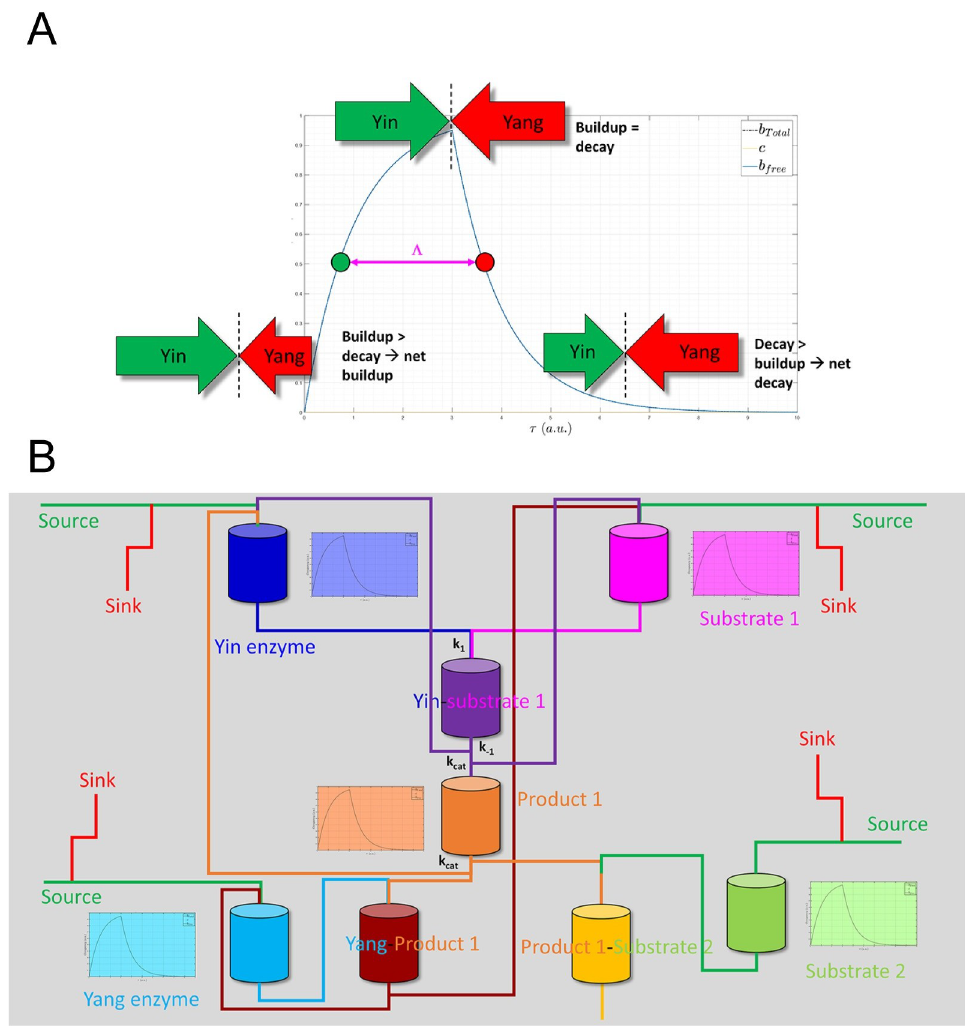
Fig 5. (A) Buildup and decay of a Yin (typically an enzyme), together with its substrate, product (and substrates thereof), Yang across their accessible states, as depicted by a plumbing system consisting of pipes, vessels, and valves. A given function-generating system is constituted from an interdependent collection of m such systems. Each system is maintained at non-equilibrium (analogous to “pressurization”) via continuous inputs and outputs of molecular species (“fluxes”). The dynamic fluid levels within the (n � m) member vessels of the overall system, which define its instantaneous state, are solved by integration of the m MDE collections ({ d γ k ( t )/ dt = rate of entry to state k–rate of exit from state k} i , where k = 1, 2, 3, ... , n, and i = 1, 2, 3, ... , m). The vessels may be connected in series or parallel. The flow rates to/from each vessel depend on the input and output valve settings (representing both the intrinsic and extrinsic free energy barriers in this simplified example), which are governed by the overall state of the system (constituting a feedback loop). (B) Dynamic counter-balancing prevents runaway exponential growth and decay of molecular species and state levels. The rates of buildup and decay consist of the net difference in Yin and Yang rates over time. The Yin-Yang balance is tipped toward the Yin during the buildup phase (left side of the blue curve) and toward the Yang during the decay phase (right side of the blue curve). The absolute rates of species or state level changes are irrelevant, except in cases where runaway behavior is functionally desirable (e.g. caspase activation). The overall buildup-decay cycle length is denoted as Λ , noting that long lived species or states likely result from slow decay rather than slow buildup (which would otherwise dampen the maximum level). Fast buildup has important implications for bound state occupancy, which are discussed later in the